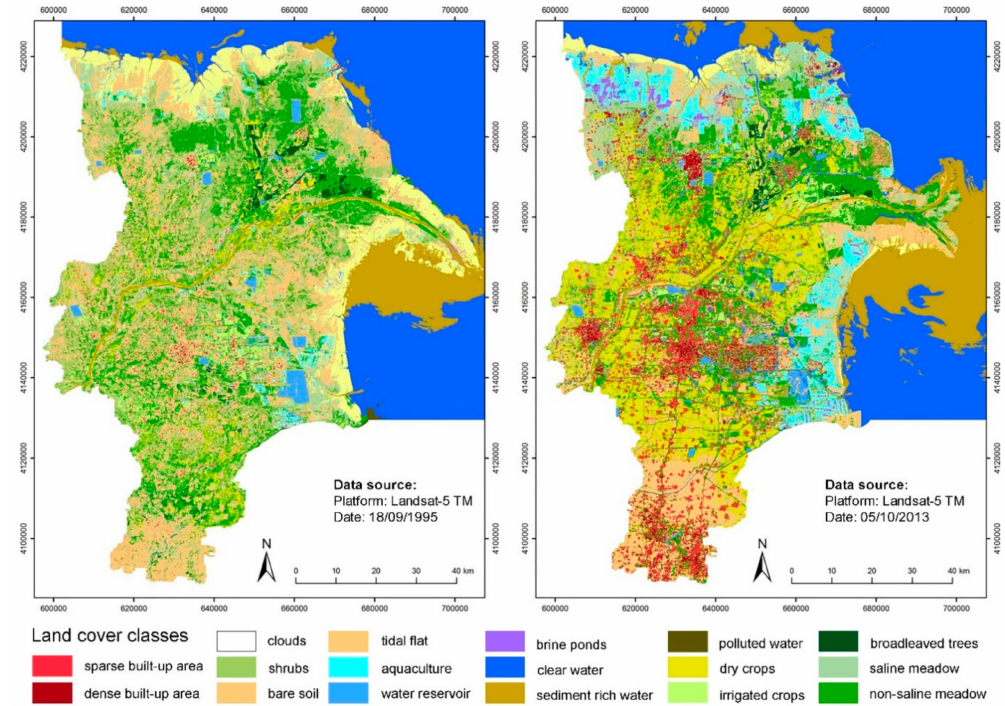
Figure 13. Results of a decision tree-based land cover, land use classification for the Yellow River Delta in China for the year 1995 ( left ) and for the year 2013 ( right ). (Adapted with permission from Ottinger et al.